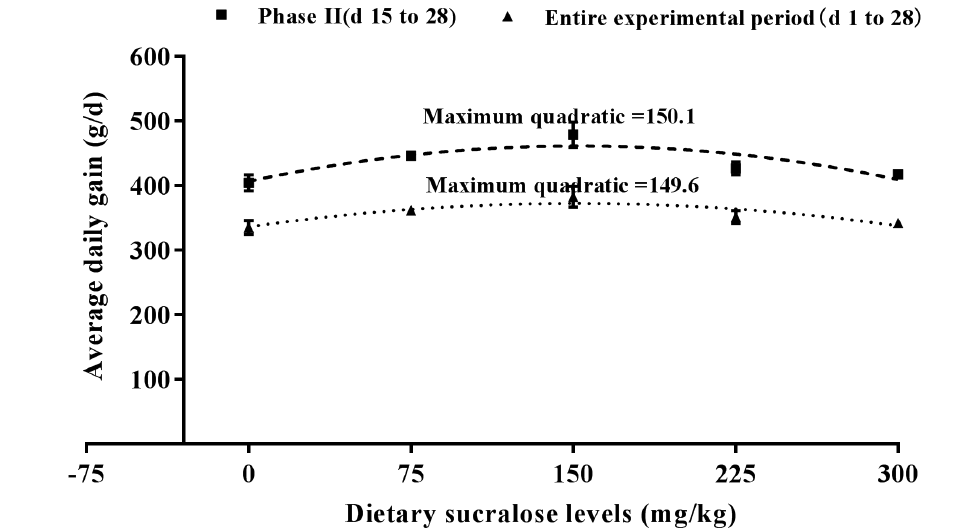
Figure 1. Fitted quadratic plot of average daily gain as a function of dietary sucralose for weaned piglets (experiment 2). The optimal dietary sucralose for phase I was 146.7 mg/kg (y = –0.0008x 2 +0.2347x+265.86, R 2 = 0.91, p<0.01), and the SE for the estimated parameters of a (–0.0008), b (0.2347), c (265.86) were 0.0005, 0.1545, 9.783, respectively. The optimal dietary sucralose for phase II was 150.1 mg/kg (y = –0.0024x 2 +0.7205x+406.70, R 2 = 0.74, p<0.01), and the SE for the estimated parameters of a (–0.0024), b (0.7205), c (406.70) were 0.0006, 0.1890, 11.96, respectively. The optimal dietary sucralose for entire experiment period was 149.6 mg/kg (y = –0.0016x 2 +0.4788x+336.21, R 2 = 0.79, p<0.01), and the SE for the estimated parameters of a (–0.0016), b (0.4788), c (336.21) were 0.0005, 0.1569, 9.936, respectively. SE, standard error.